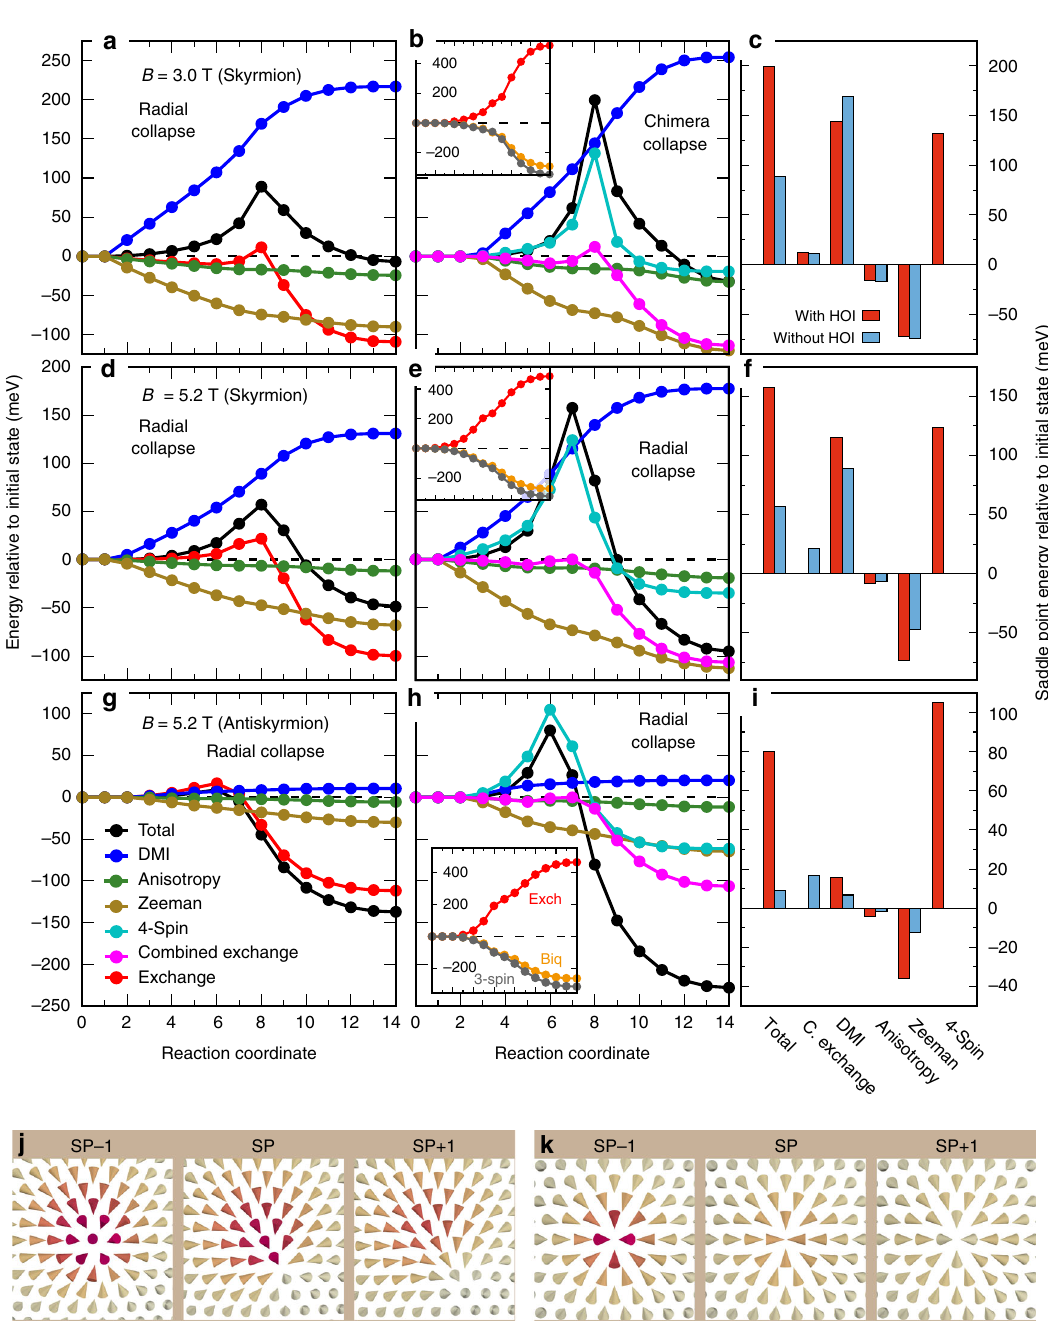
Fig. 3 Minimum energy paths of skyrmion and antiskyrmion collapse in Pd/Fe/Rh(111). Total and individual energy contributions along minimum energy paths neglecting and including HOI. Combined exchange for simulations with HOI denotes the sum of exchange, biquadratic, and three-site four spin interaction. a Radial collapse of an isolated skyrmion at B = 3 T neglecting HOI. b Chimera collapse of an isolated skyrmion at B = 3 T including HOI. c Energy decomposition at the saddle point of the path shown in a , b with respect to the initial (skyrmion) state. d , e Radial collapse of an isolated skyrmion at B = 5.2 T neglecting and including HOI, respectively. f Energy decomposition at the saddle point of the path shown in d , e with respect to the initial (skyrmion) state. g , h Radial collapse of an isolated antiskyrmion at B = 5.2 T neglecting and including HOI, respectively. i Energy decomposition at the saddle point of the path shown in g , h with respect to the initial (antiskyrmion) state. Inset of b , e , h The exchange, biquadratic and three-site four spin (3- spin) terms. j , k Spin structures before (SP-1), after (SP + 1) and at the saddle point (SP) for the chimera collapse in b and the radial collapse in e , respectively. For brevity, the two-site, three-site, and four-site four spin interactions are denoted as Biq, 3-spin and 4-spin, interaction and the biquadratic terms which we denote as combined exchange to combined exchange at the saddle point is relatively exchange. The comparison of Fig. 3a, b shows that the exchange small (Fig. 3c, f, i). and the combined exchange behave qualitatively quite similar along The four-site four spin interaction acts in a qualitatively the path — which is also true for the other two collapse mechanisms different way compared to all other terms. For all considered (Fig. 3d, e and Fig. 3g, h). The absolute energy change from paths (Fig. 3b, e, h), it gains in energy slowly as one approaches